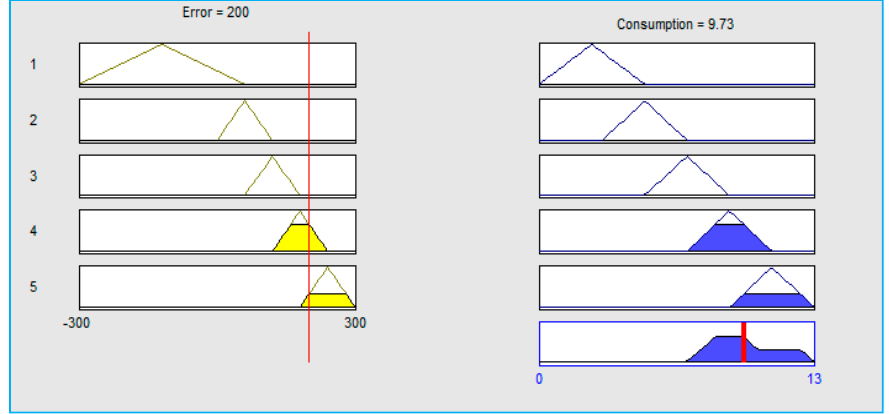
Figure 18. Example of fuzzy rule used in air quality fuzzy logic.